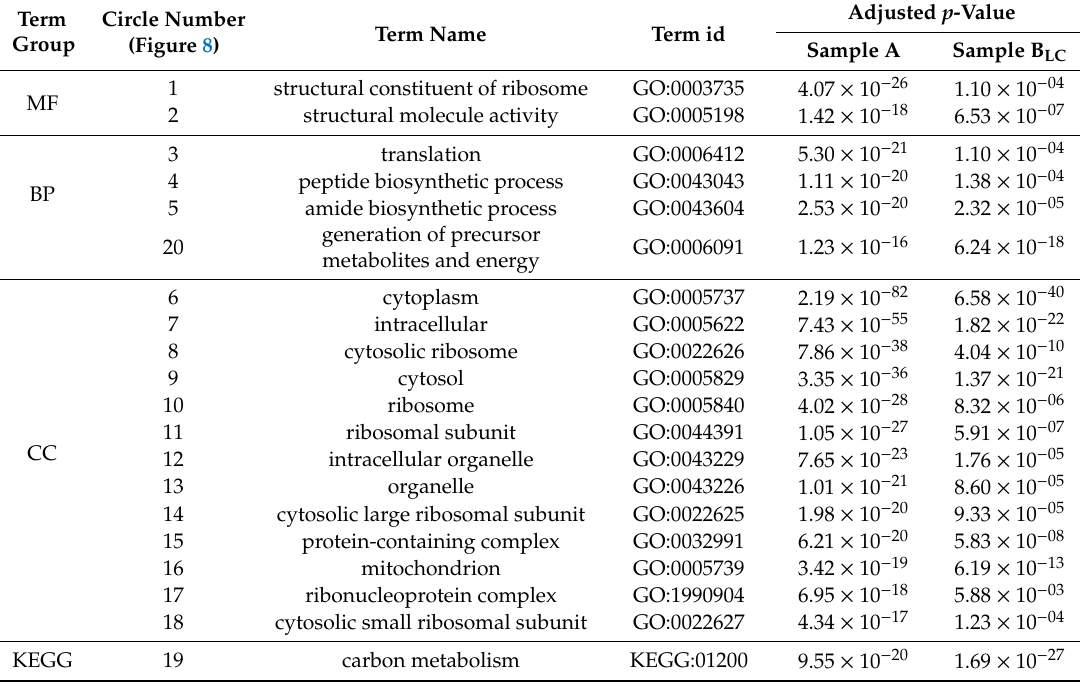
Figure 8. Manhattan plot of GO terms and biological pathways (KEGG) enrichment analysis, results of a multiquery with the two input gene lists (A and B LC , obtained from protein). The x-axis represents functional terms that are grouped and color-coded by data sources (e.g., Molecular Function, MF, Biological Process, BP, Cellular Component, CC from GO, and KEGG pathways, are red, green, orange, and violet, respectively). The y-axis shows the adjusted enrichment p -values in negative log 10 scale). Term circles with p -values less than 1.0 × 10 − 16 (highly significant) in at least one sample are highlighted and numbered. The circle sizes are in accordance with the corresponding term sizes (i.e., larger terms, which means more hits of the specific term retrieved from the dataset, correspond to larger circles). Table 2. GO terms and biological pathways (KEGG) enrichment analysis.